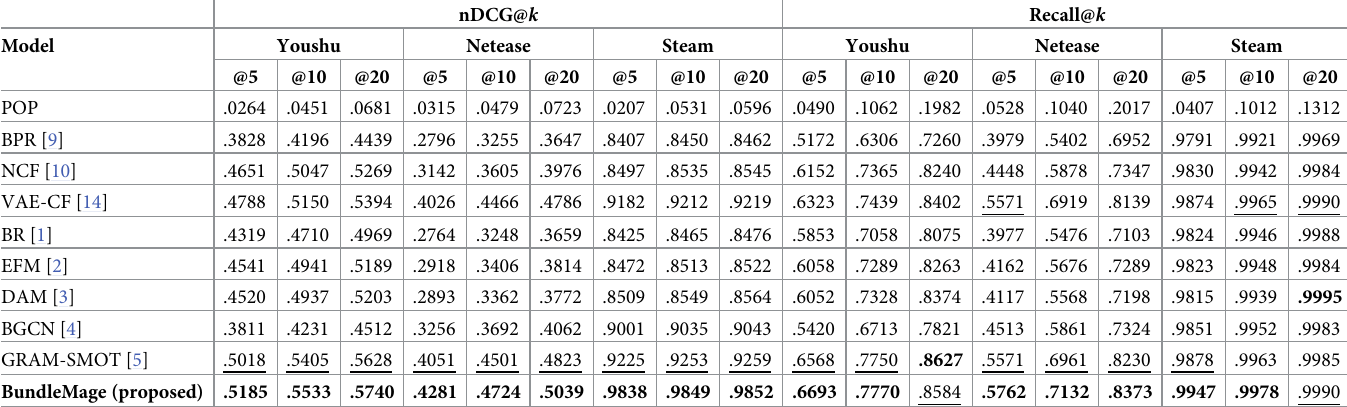
Table 3. Performance of BundleMage and competitors for bundle matching with respect to nDCG and Recall.